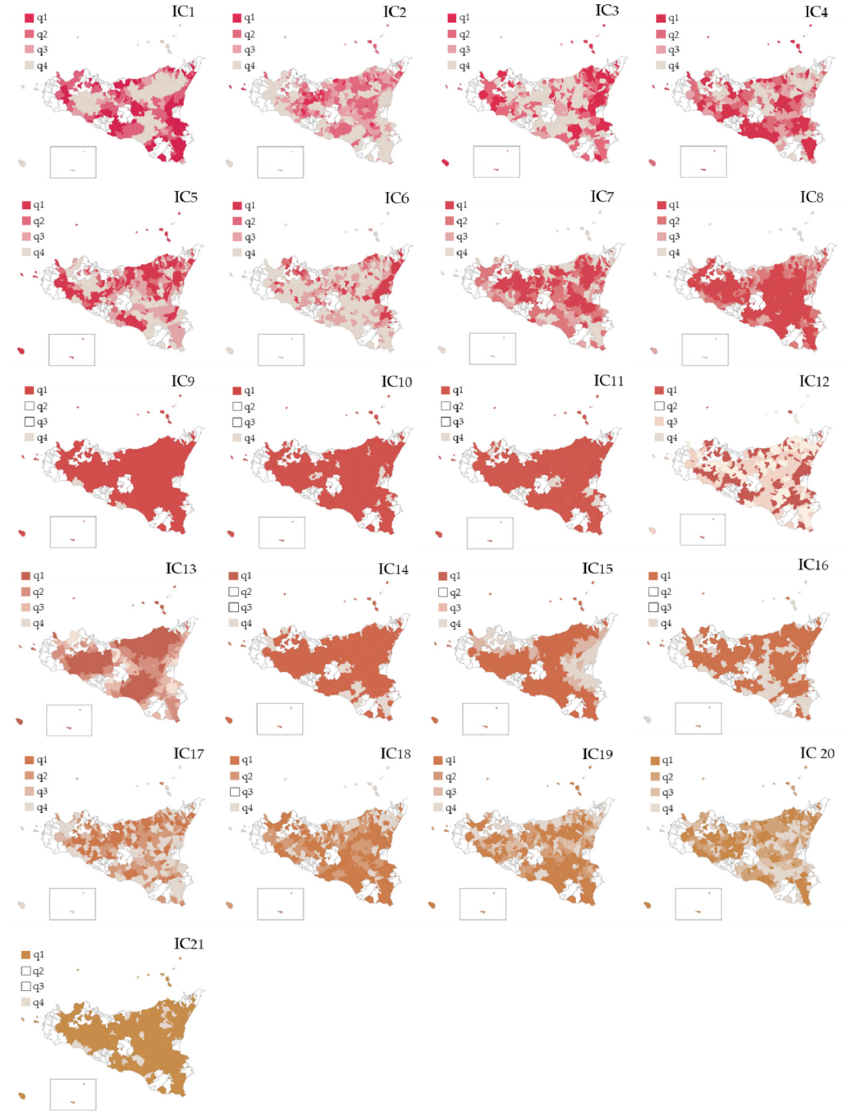
Figure 12. Mapping of Infrastructure Capital indicators. (Authors’ elaboration.) With reference to the second quartile, Figure 12 shows: clusters of municipalities pre- dominantly falling in the central and eastern areas of Sicily for IC1; small clusters of mu- nicipalities predominantly falling in the central area of Sicily for IC2; clusters of munici- palities predominantly falling in the central-western and eastern areas of Sicily for IC3; clusters of municipalities predominantly falling in the central area of Sicily for IC4; small clusters of municipalities predominantly falling in the north-central area of Sicily for IC5; small clusters of municipalities predominantly falling in the north-western area of Sicily for IC6; clusters of municipalities predominantly falling in the central and southern areas of Sicily for IC7; clusters of municipalities predominantly falling in the southern and northern area of Sicily for IC8; no municipalities falling in the second quartile for IC9, IC10, and IC11; no municipalities falling in the second quartile for IC12; clusters of mu- nicipalities falling in the central and eastern area of Sicily for IC13; no municipalities fall- ing in the second quartile for IC14, IC15, and IC16; clusters of municipalities